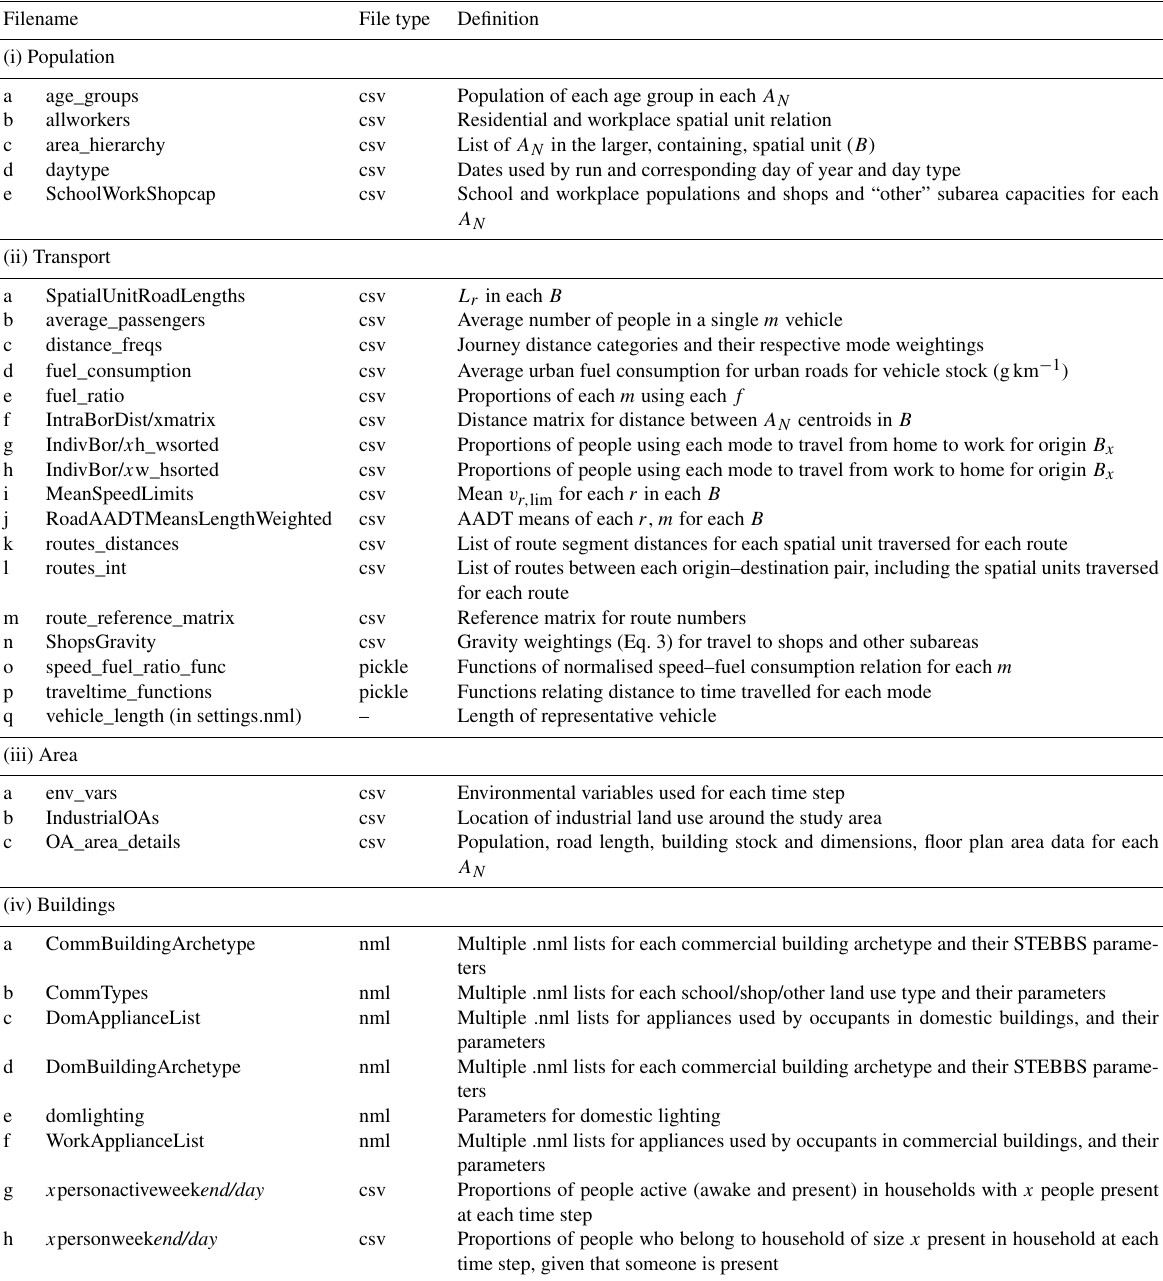
Table D1. Data examples. More details (example structure, units, raw data source, location in repository, and location of use in code) can be found at https://doi.org/10.5281/zenodo.3745523 (Capel-Timms et al., 2020). Data indicated in Table 6 are also